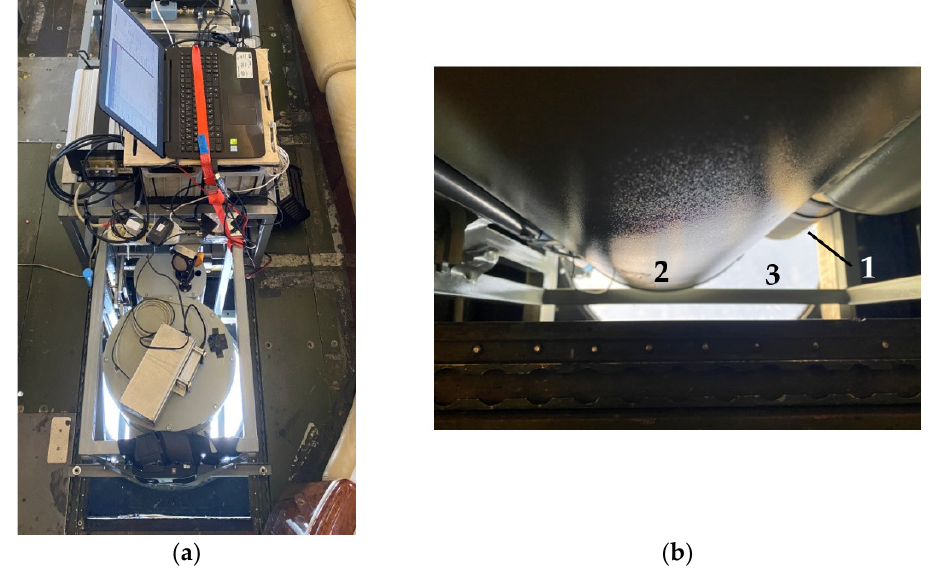
Figure 8. ( a ) Photo of an airborne lidar; ( b ) transmitting aperture and additional tube (1) and receiving aperture (2) and aircraft hatch (3).